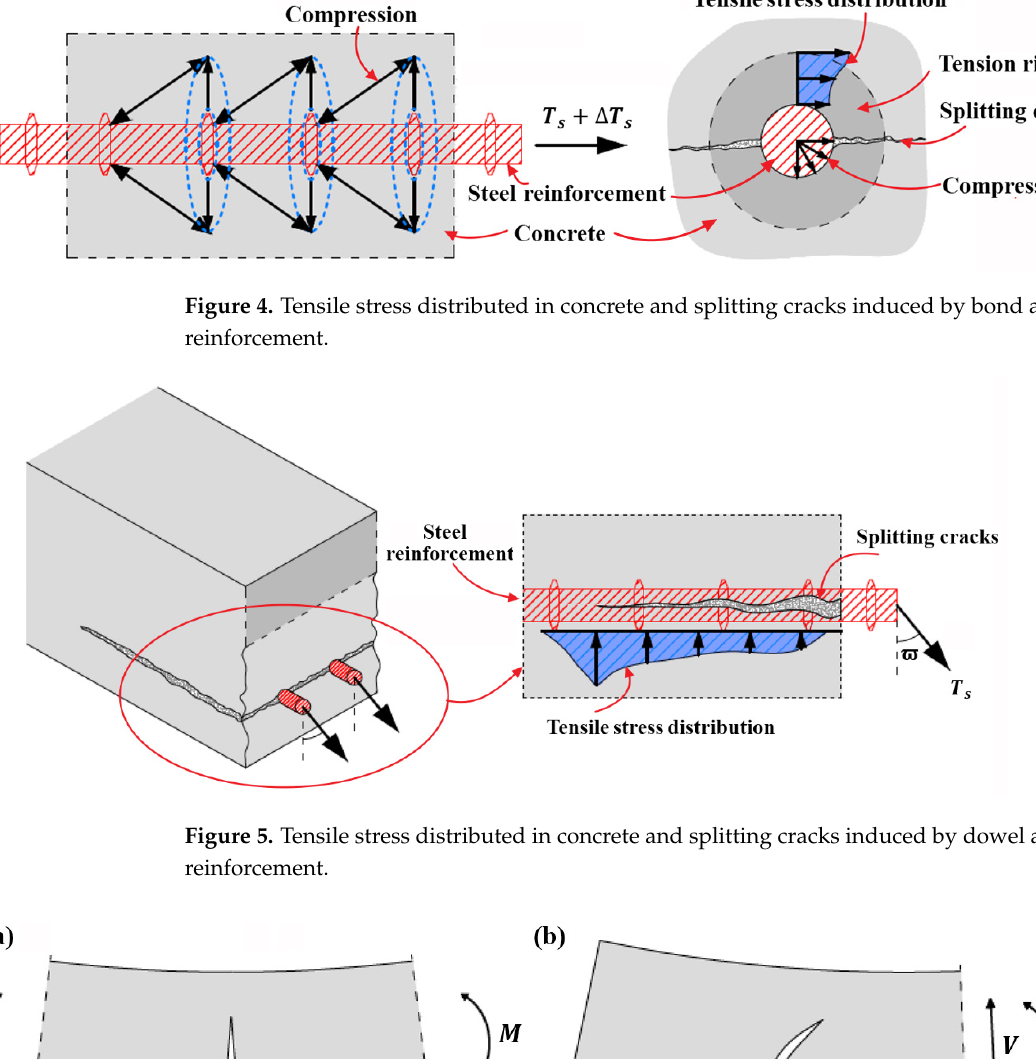
Figure 4. Tensile stress distributed in concrete and splitting cracks induced by bond action of steel reinforcement.